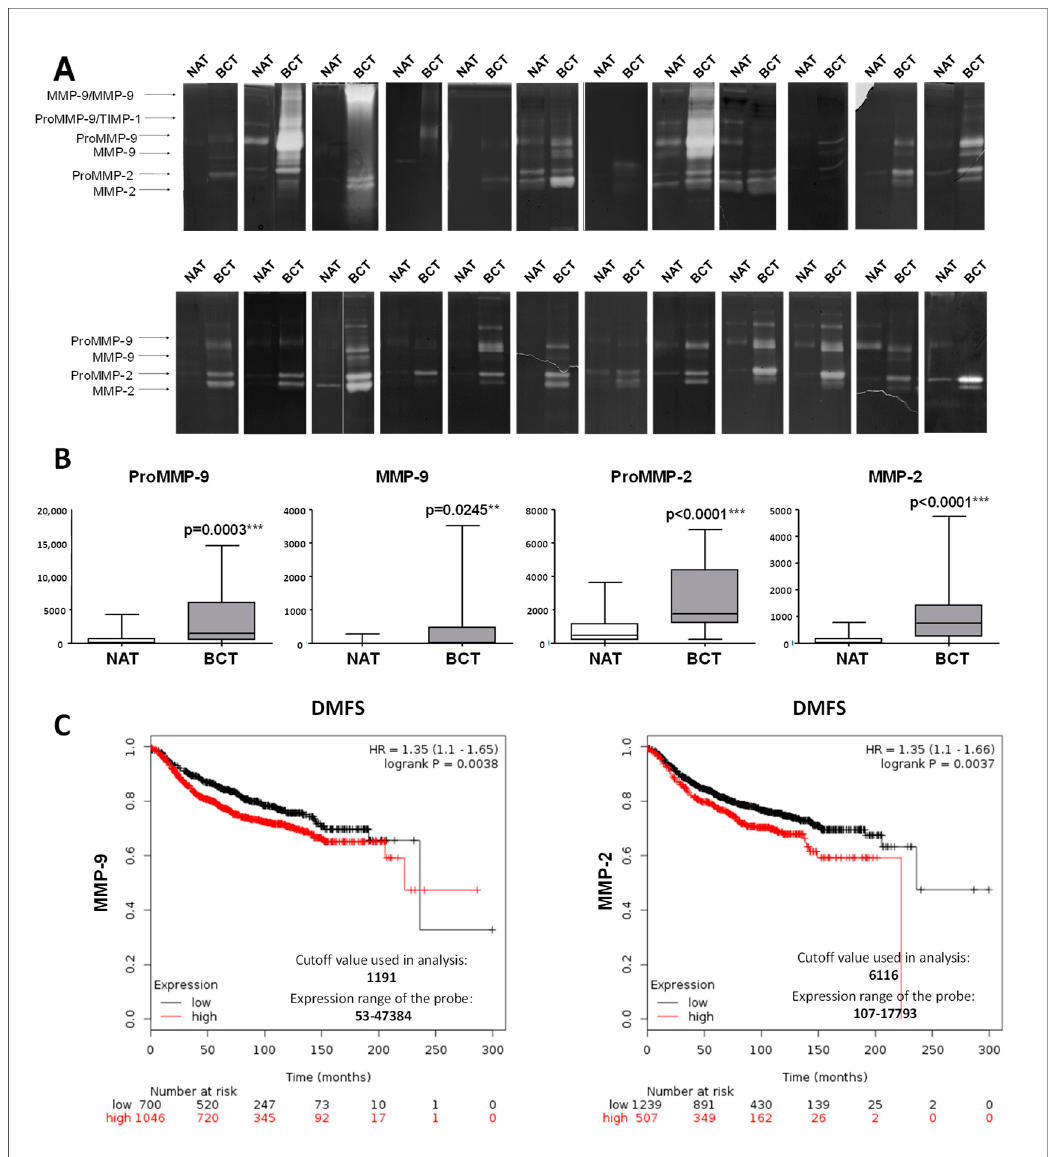
Figure 2. MMP-9 and MMP-2 enzymatic activity in normal and breast cancer tissues and prognostic significance. ( A ) Gelatin zymography was performed using total lysates from breast tumors (BCT) and paired non-tumoral adjacent tissues (NAT); n = 24. ( B ) Densitometric analysis of the gelatinolytic bands. Each data point is the average of three independent experiments. Error bars represent standard deviation and p values indicate statistical significance. ( C ) Survival analysis in breast cancer patients obtained from Kaplain–Meir plotter database relative to MMP-9 and MMP-2 expression.